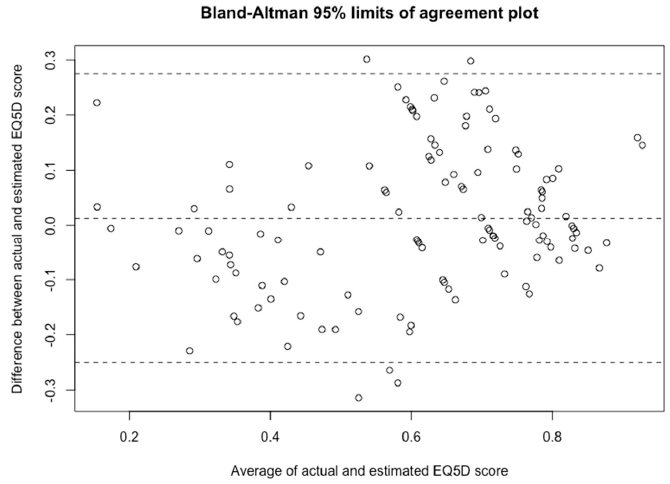
Figure 2. Bland-Altman agreement plot. X axis is the average score of the actual and estimated EQ-5D score of the CAT reg model. Y axis is the difference between the two. Each dot represents a patient. The three dashed lines are upper 95% limits of agreements (mean + 1.96 SD), mean difference, and lower 95% limits of agreements (mean − 1.96 SD).